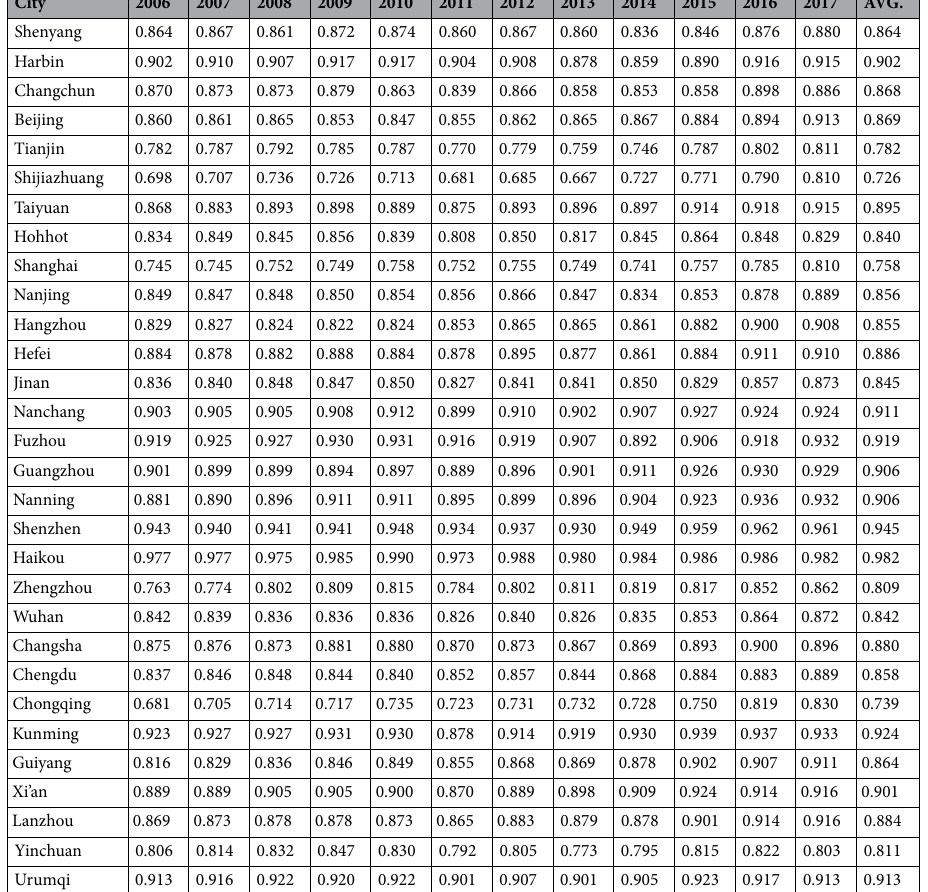
Table 6. CCD of low-carbon-environment index from 2006 to 2017.